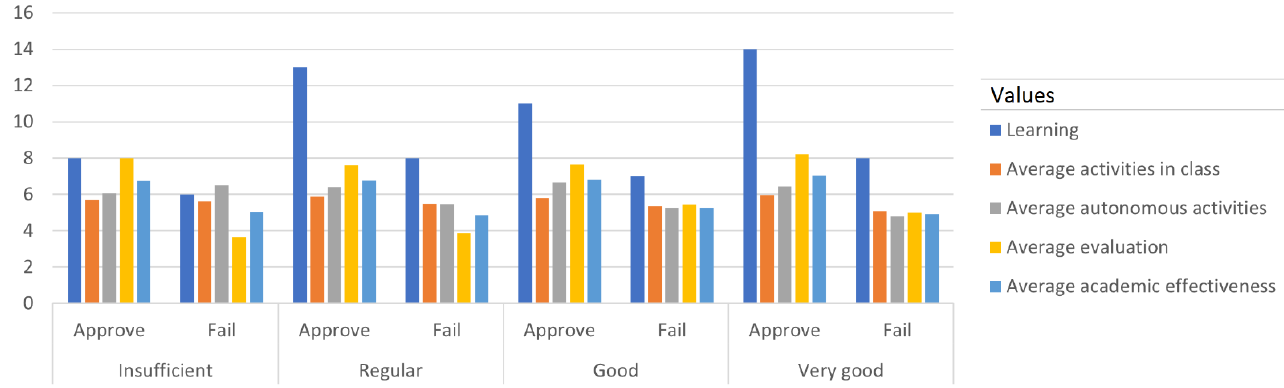
Figure 2. Graph of the trend analysis for the 2019 period.